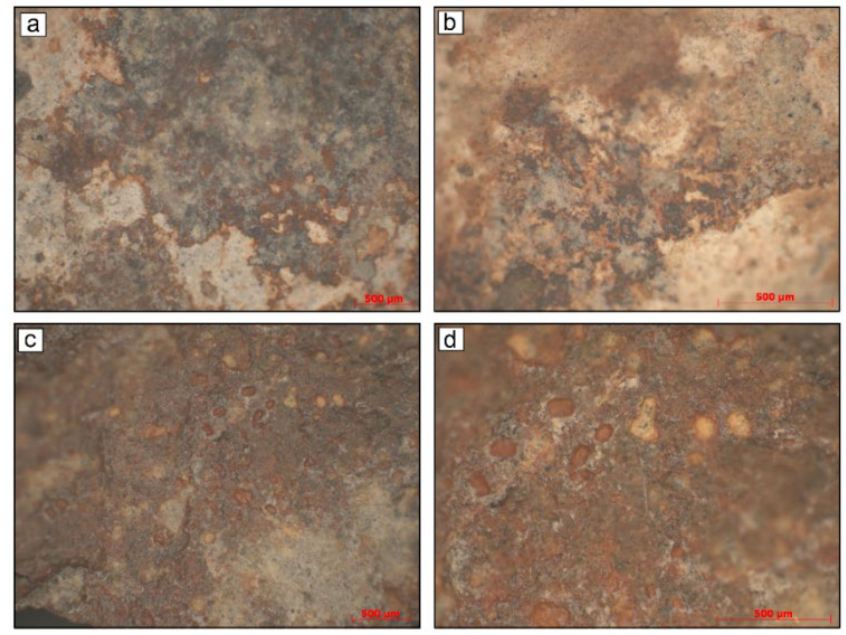
Figure 7. OM images for the red pigment from Bâtca Doamnei : ( a , b ) vessel exterior; ( c , d ) vessel interior (( a , c ) 50×; ( b , d ) 10×).